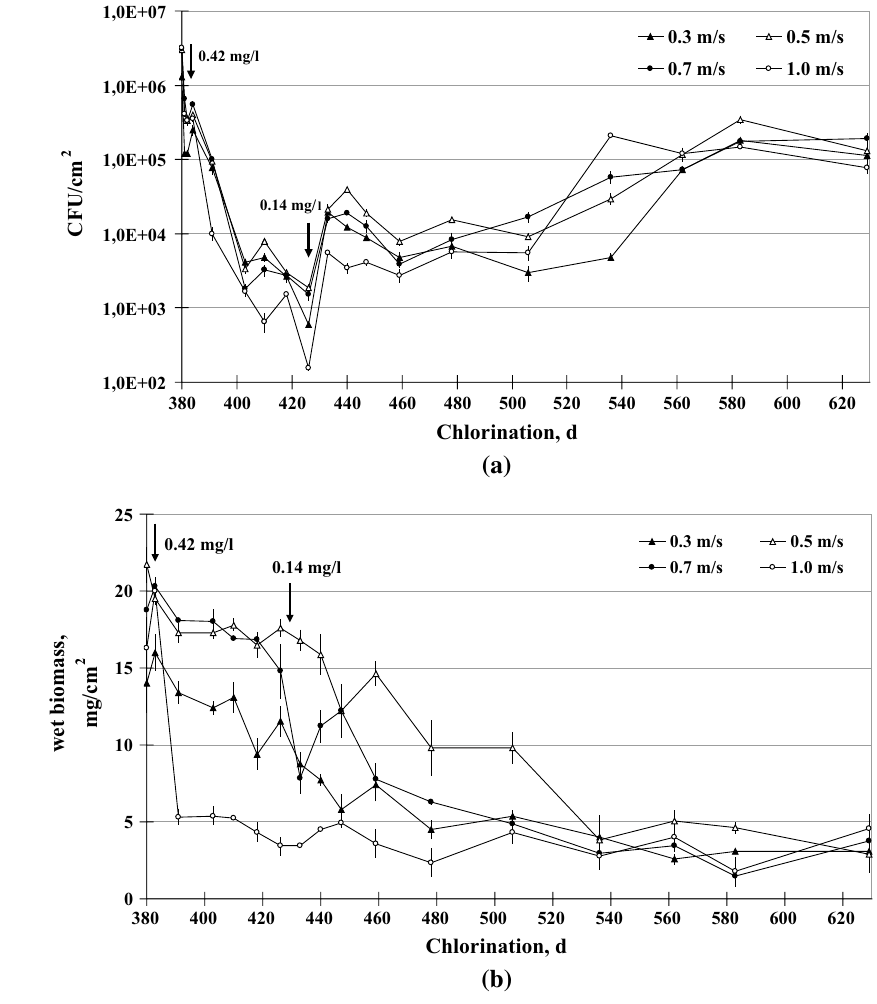
Fig. 3 Dynamics of the biofilms under the flow velocities of 0.3 m/s, 0.5 m/s, 0.7 m/s or 1 m/s during both successive water chlorination regimes to 0.42 mg/l or 0.14 mg/l free chlorine: a bacterial